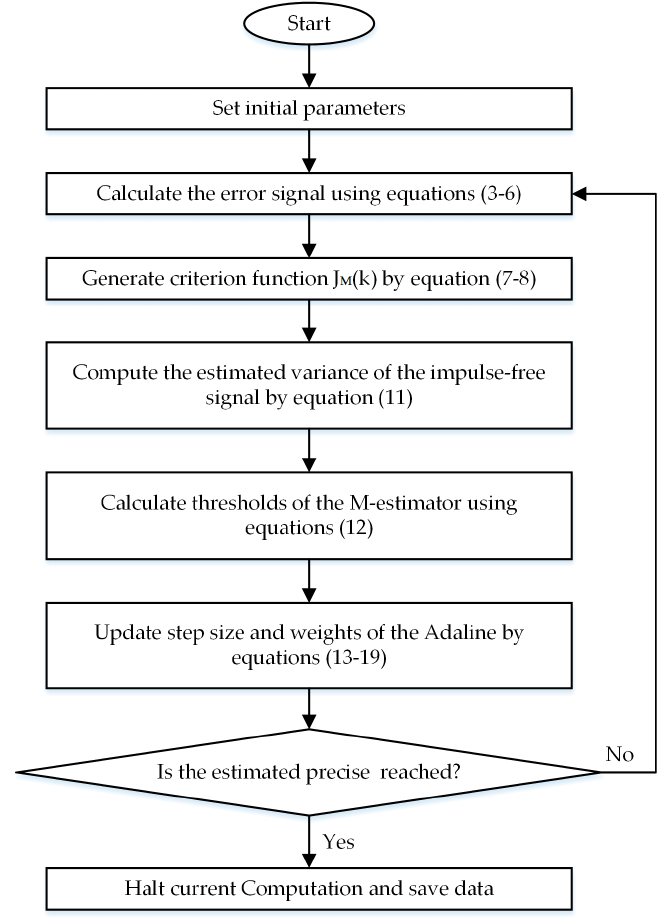
Figure 5. Flow chart of the least mean M-estimate algorithm.